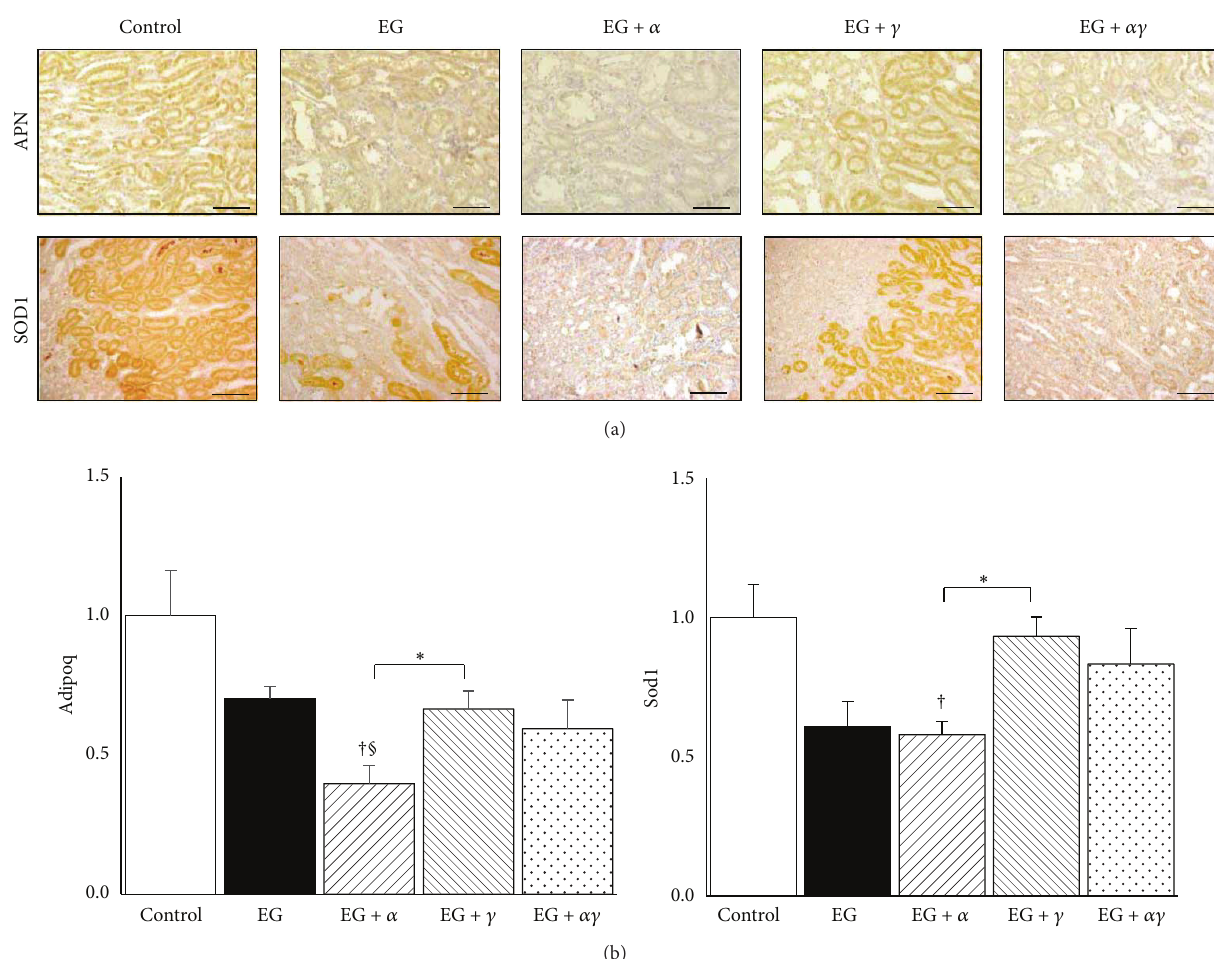
Figure 5: Anti-inflammatory and oxidative stress gene expression in model rat kidneys. (a) Distribution of anti-inflammatory and oxidative stress-related gene expressions in rat kidneys obtained on day 14. APN, adiponectin; SOD1, superoxide dismutase 1. Magnification: 200x. Scale bar = 100 𝜇 m. (b) Gene expression was measured by qRT-PCR using TaqMan assays ( 𝑛 = 6 for all groups). Data are presented as the mean ± SE. ∗ 𝑝 < 0.05 among EG + 𝛼 , EG + 𝛾 , and EG + 𝛼𝛾 groups; † 𝑝 < 0.05 compared with the control group; § 𝑝 < 0.05 compared to the EG